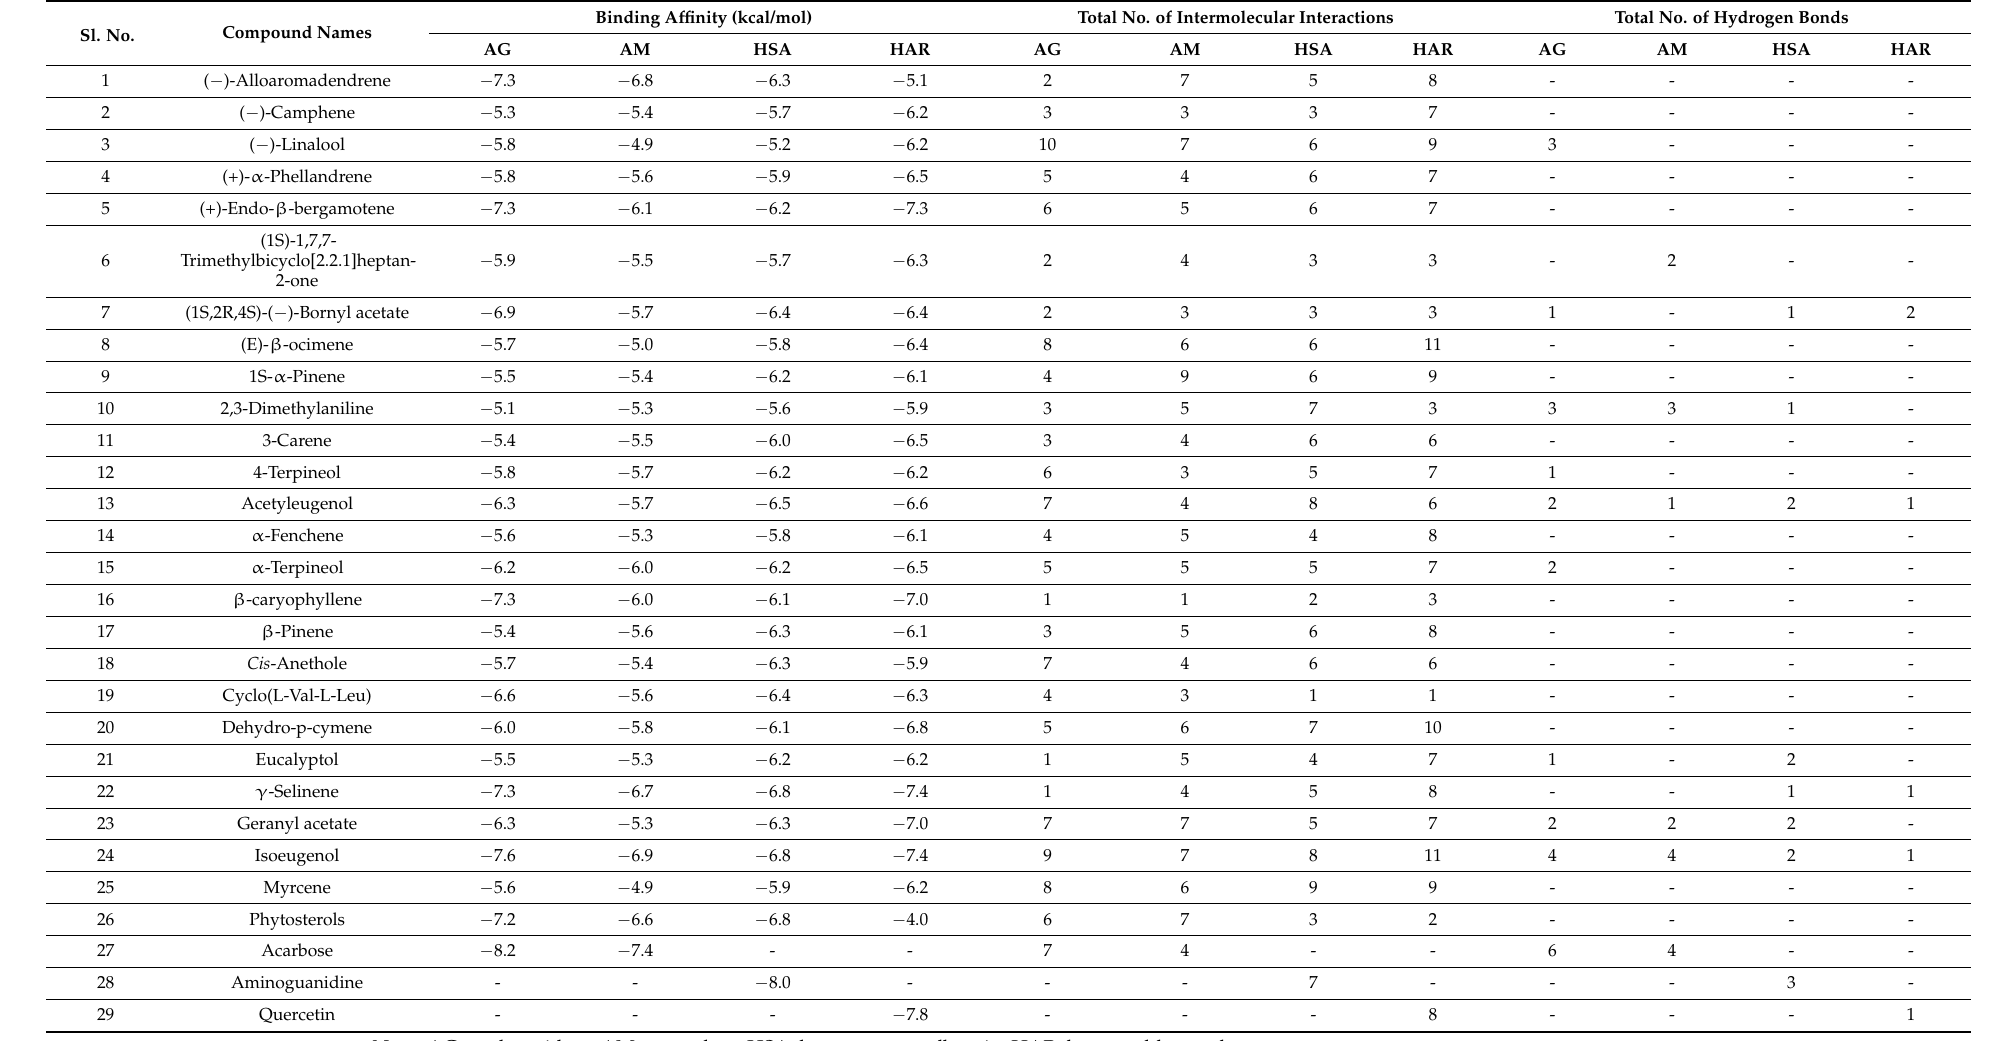
Table 3. Name of the compounds, respective binding affinity, and total non-bonded interactions and hydrogen bonds, with their respective target proteins. Sl.